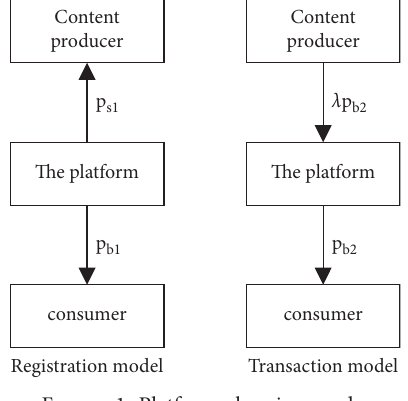
Figure 1: Platform charging mode. Table 1: Denotations for modelling.